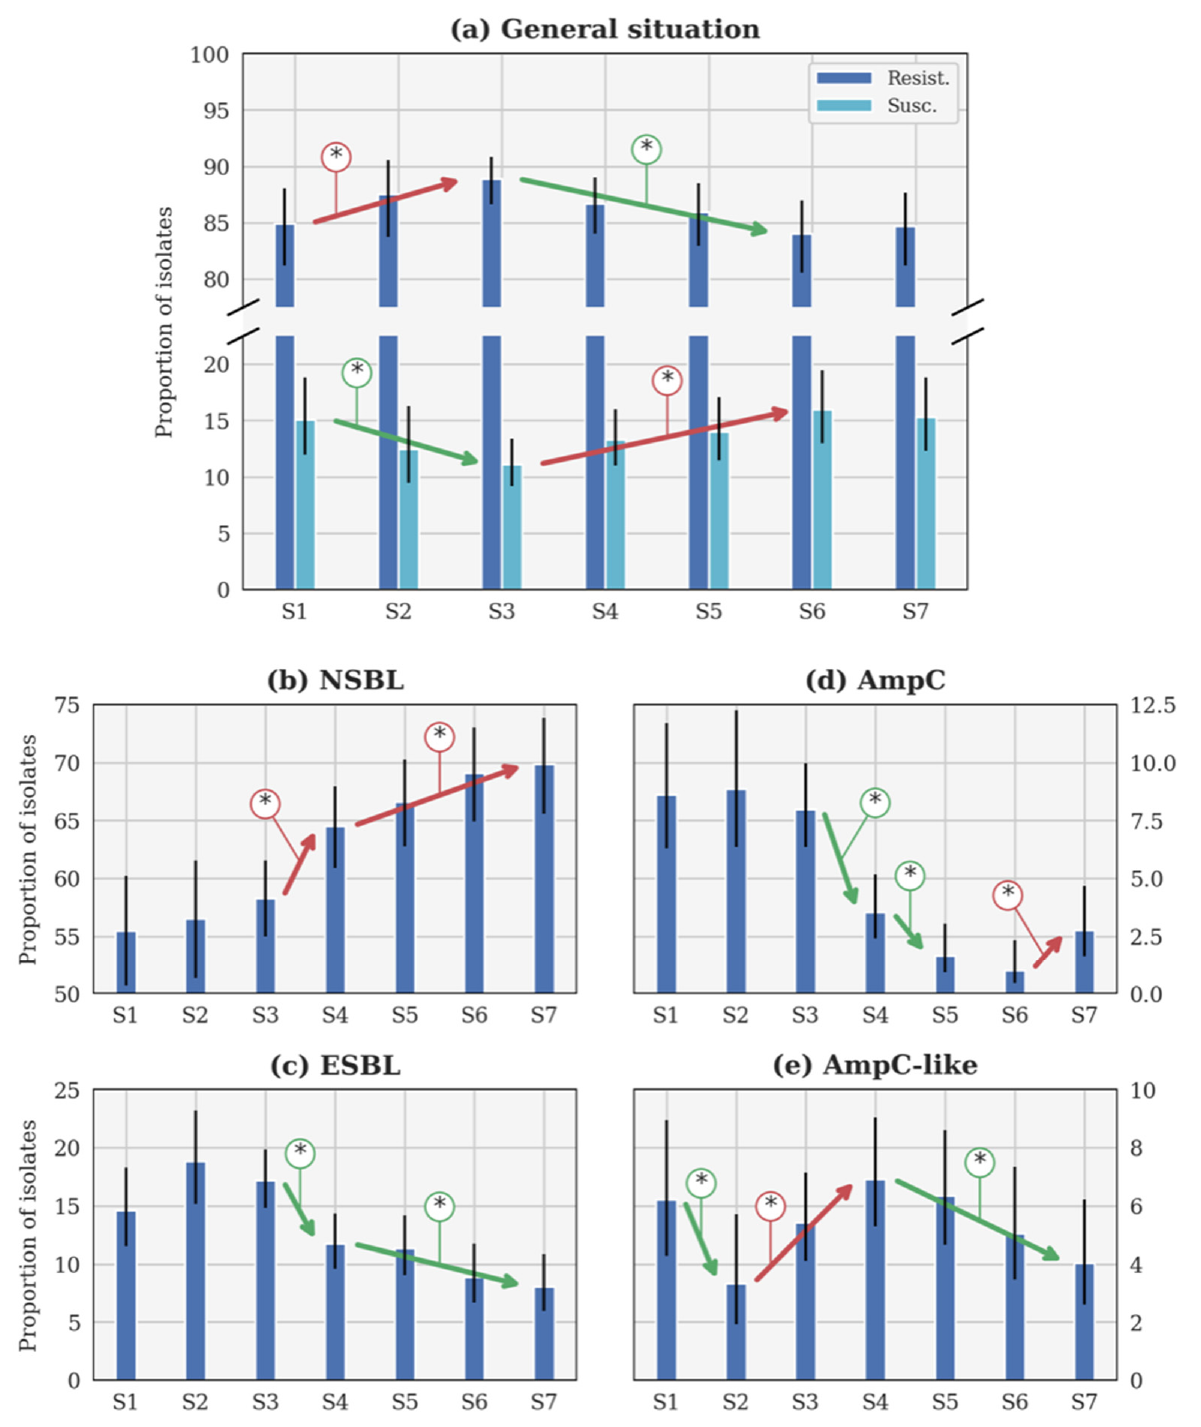
Figure 2. Evolution of the theoretical proportion of resistant isolates of the seasons ( a ) across all categories, as well as for ( b ) narrow-spectrum β -lactamase (NSBL), ( c ) extended-spectrum β -lactamase (ESBL), ( d ) cephalosporinase (AmpC), and ( e ) NSBL with nonsensitivity to cefoxitin (AmpC-like) categories. In each case, the blue histogram shows the maximum a posteriori and the black line shows the 95% confidence interval. The coloured lines with an asterisk show the statistically significant difference. S1: 2014–2015. S2: 2015–2016. S3: 2016–2017. S4: 2017–2018. S5: 2018–2019. S6: 2019–2020. S7: 2020–2021. Important note, scales were different for each phenotype for the clarity of the figures.